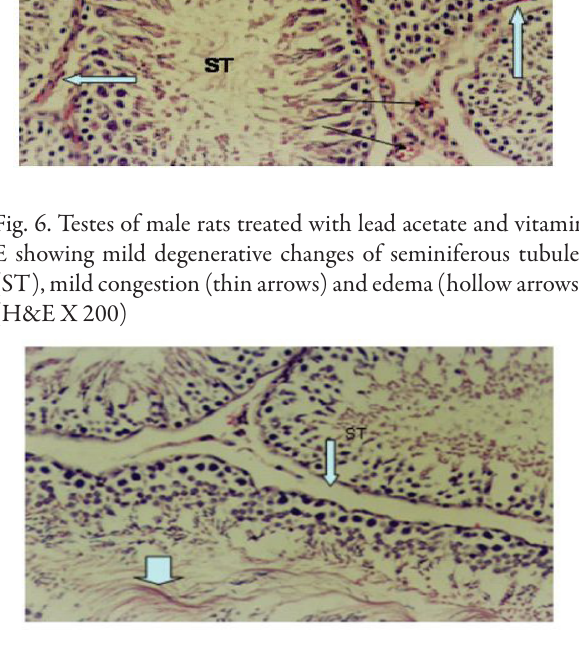
Fig. 7. Testes of male rats treated with lead acetate ant vitamin E showing nearly normal seminiferous tubules with mild odema (thin hollow arrow) and necrosis (big hollow arrow) (H&e X 200)